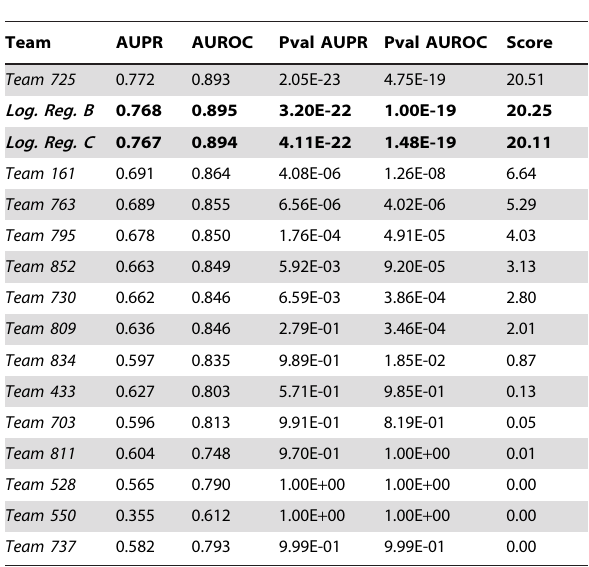
have negative SRCs; as a matter of fact, it is known that accessibility, hydrophilicity and flexibility have negative correlations with the reactivity, while it is more difficult to interpret the negative correlation of beta-turn propensity. Both model B and C include only three scale-based features. Given the SRCs and their plausible explanations, both models have only an unexpected regression coefficient, in correspon- dence of flexibility (model B) and antigenicity (model C). N No well-defined knowledge is available about the influence of the amino acid frequencies on the peptide reactivity. So, we assessed the correlation of the corresponding SRCs with the different amino acid scales (antigenicity: 0.29; accessibility: 2 0.66; hydrophilicity: 2 0.69; flexibility: 2 0.52; beta-turn propensity: 2 0.19). The sign of the correlations (i.e. Spearman correlation) follows the same pattern of the scale-based features: all the features are negatively correlated with peptide reactivity except for antigenicity. Finally, we evaluated the reliability of the regression coefficients of the multivariate model in terms of their correlation with the SRCs. Model B showed a good positive correlation between the regression coefficients and the correspondent SRCs (i.e. Spearman correlation = 0.496 and p-value = 0.028), while in model C no correlation was found (i.e. Spearman correlation = 2 0.075 and p-value = 0.753). Based on all these considerations, we selected model B as the best final model, even if model C had a higher F-measure. Evaluation of the model. The selected model was used to generate predictions on the test set data (3421 positive and 10219